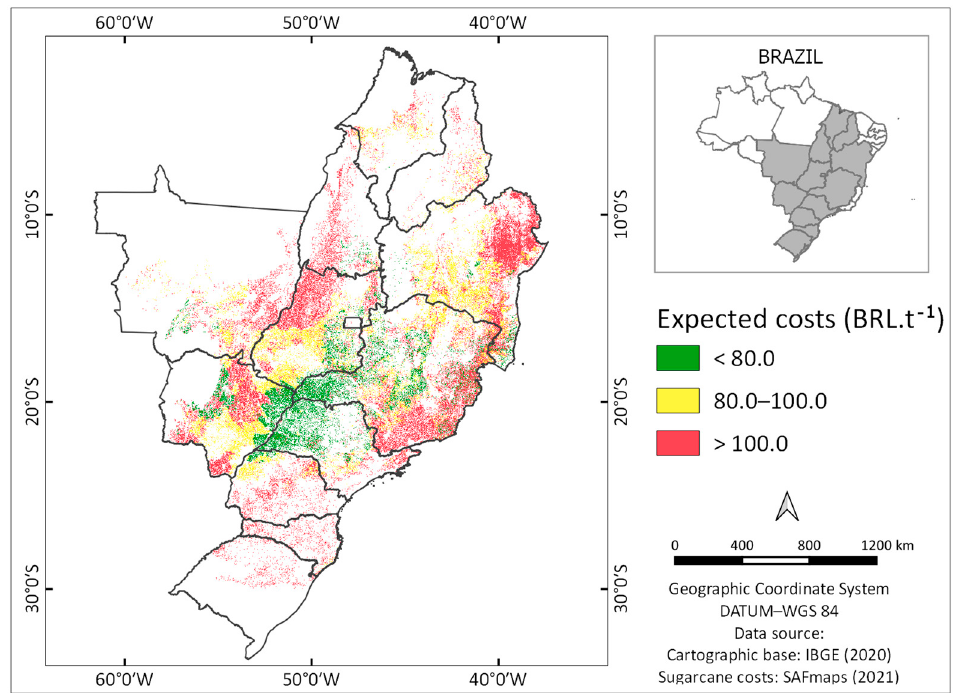
Figure 3. Estimated costs of sugarcane in a five-year cycle (including transport to a nearby mill) in twelve Brazilian states, considering the production over pasturelands.